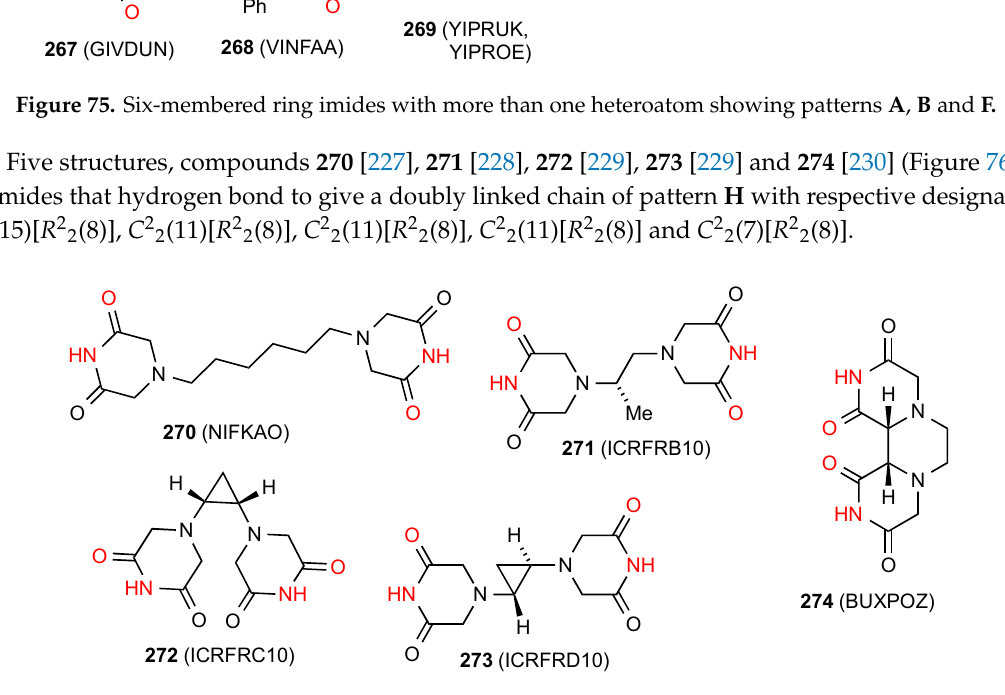
Figure 76. Six-membered ring bis imides with more than one heteroatom showing pattern H.